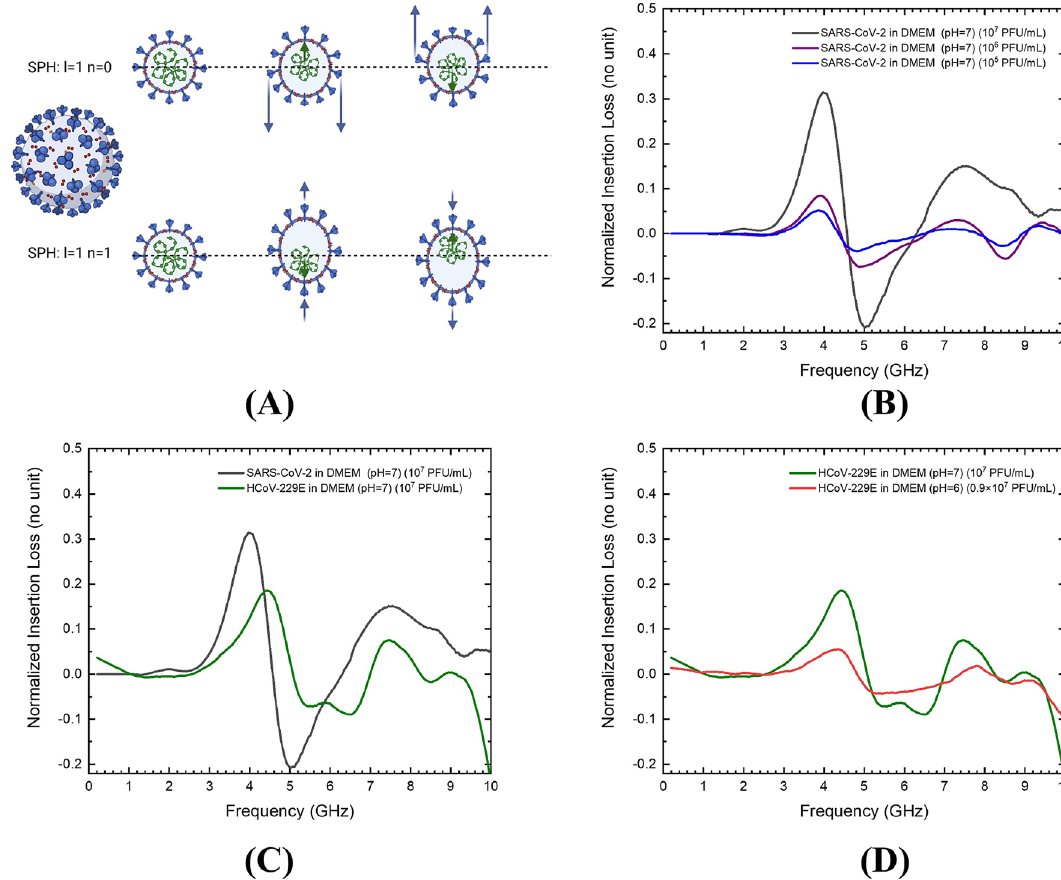
Figure 2. The resonance process of SARS-CoV-2 and its microwave absorption spectra for different concentrations compared with HCoV-229E under different experimental conditions. ( A ) Schematic illustrating the displacement of two dipolar modes of the spherical particle, with angular momentum l = 1 and with quantum numbers n = 0 or 1, driven by the electric field generated by the microwave. The blue and green arrows represent the displacements of the shells and the core respectively. Under the viewpoint of two-body problem, for the vibration mode of n = 0, the motion of the virion is like an inner cylinder and an outer ring that are moving in opposite directions. For the other vibration mode of n = 1, the motion behaves like a core and a shell that are moving in opposite directions. ( B ) Normalized insertion loss for different concentrations of SARS-CoV-2 (10 7 PFU/mL, black-colored line; 10 6 PFU/mL, purple-colored line; and 10 5 PFU/mL, blue- colored line) purified in DMEM. Every spectrum in the figure represents one measurement of the normalized IL. ( C ) The normalized insertion loss of SARS-CoV-2 (black-colored line) and HCoV-229E (green-colored line) with the same viral concentration (10 7 PFU/mL) and purified in the same medium DMEM (pH 7.4). The dataset of SARS-CoV-2 in this plot is the same as ( B ) for the comparison. ( D ) The normalized insertion loss of HCoV-229E in DMEM with different acidity levels. (green-colored line: pH 7, 10 7 PFU/mL; red-colored line: pH 6, 0.9 × 10 7 PFU/mL) The dataset of HCoV-229E in neutral medium in this plot is the same as ( C ) for the